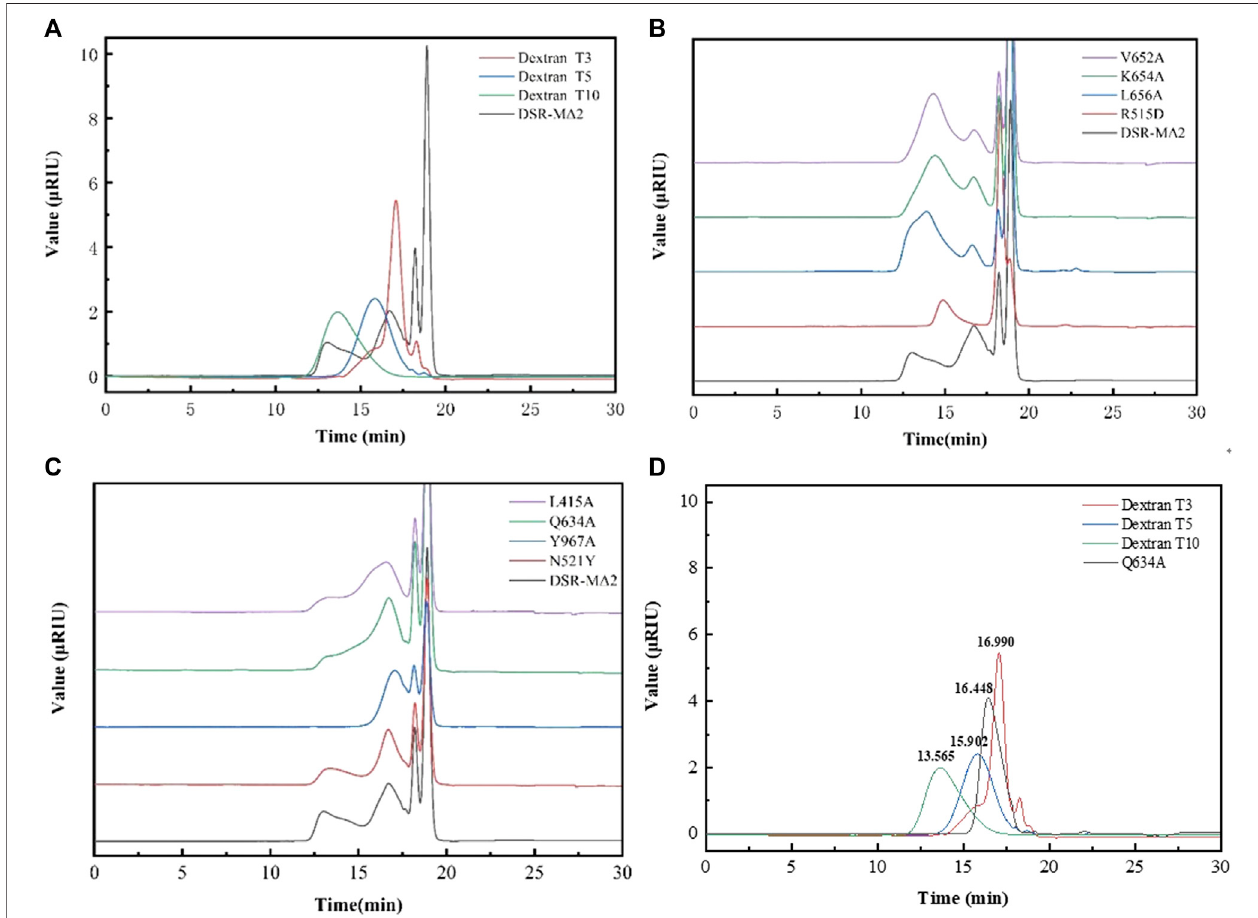
FIGURE3| AnalysisofthemolecularweightofdextranssynthesizedbyDSR-M Δ 2anditsvariantsfromsucrose. (A) DextransynthesizedbyDSR-M Δ 2.T3,T5andT10 are the standardswith3,000 Da, 5,000 Daand 10,000 Da; (B) Dextransynthesized byDSR-M Δ 2 mutantswithhigherratio ofH-dextran; (C) Dextran synthesizedbyDSR-